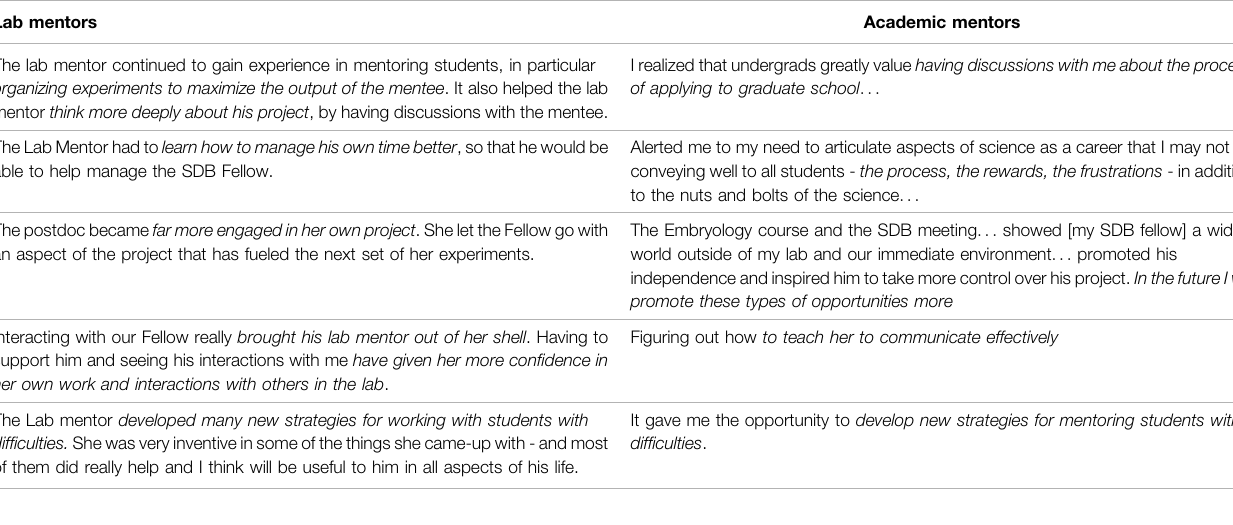
TABLE 4 | Research publications with data from Choose Development! fellows research